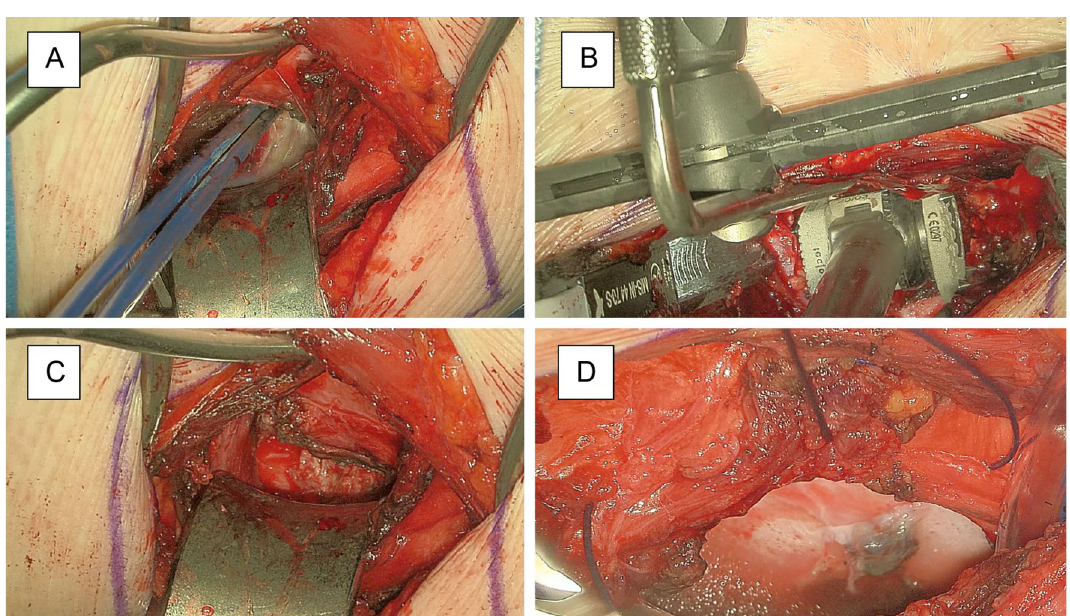
Figure 8. Exemplary case 2: thoracic corpectomy and vertebral body replacement with a carbon fiber- reinforced PEEK implant for metastatic disease. ( A ) Transpleural minithoracotomy approach for vertebral body resection; ( B ) Vizualization of vertebral body replacement; ( C ) Providing different angles of view in the depth enables adequate preparation and hemostasis; ( D ) Watertight closure of pleural cavity after chest tube